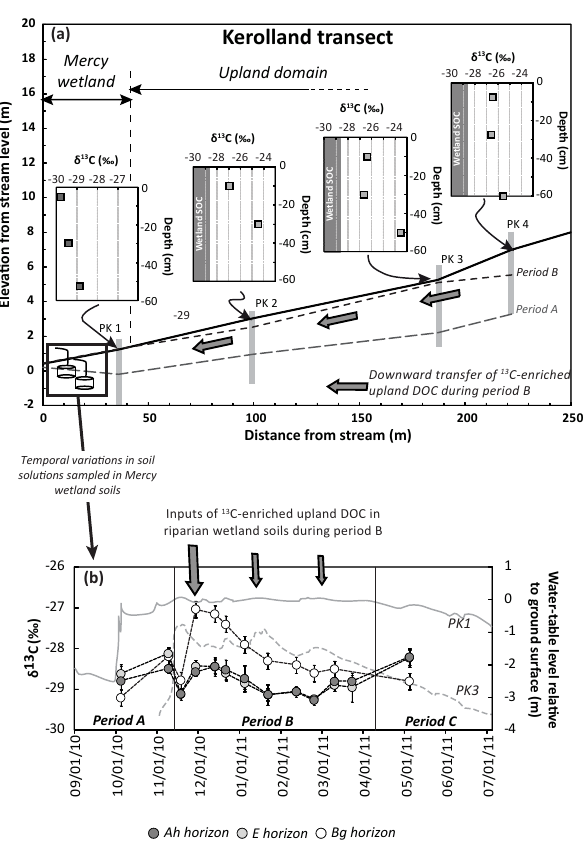
Figure 2. Sketch illustrating: (a) spatial variability of δ 13 C SOC val- ues for soil organic carbon from the riparian wetland domain to the hillslope domains of the Kervidy-Naizin catchment. Dashed lines represent the water table level along the upland–wetland transect during periods A and B. Grey arrows represent the transfer of 13 C- enriched DOC from upland soils to wetland soils ; and (b) seasonal variations of the δ 13 C DOC values in riparian wetland soils in phase with water table fluctuations. Grey arrows illustrate the mixing be- tween wetland DOC and upland DOC in riparian soils during period B. The gradual decrease in the arrow size symbolises the decrease of upland DOC inputs. Data from Lambert et al. (2011,